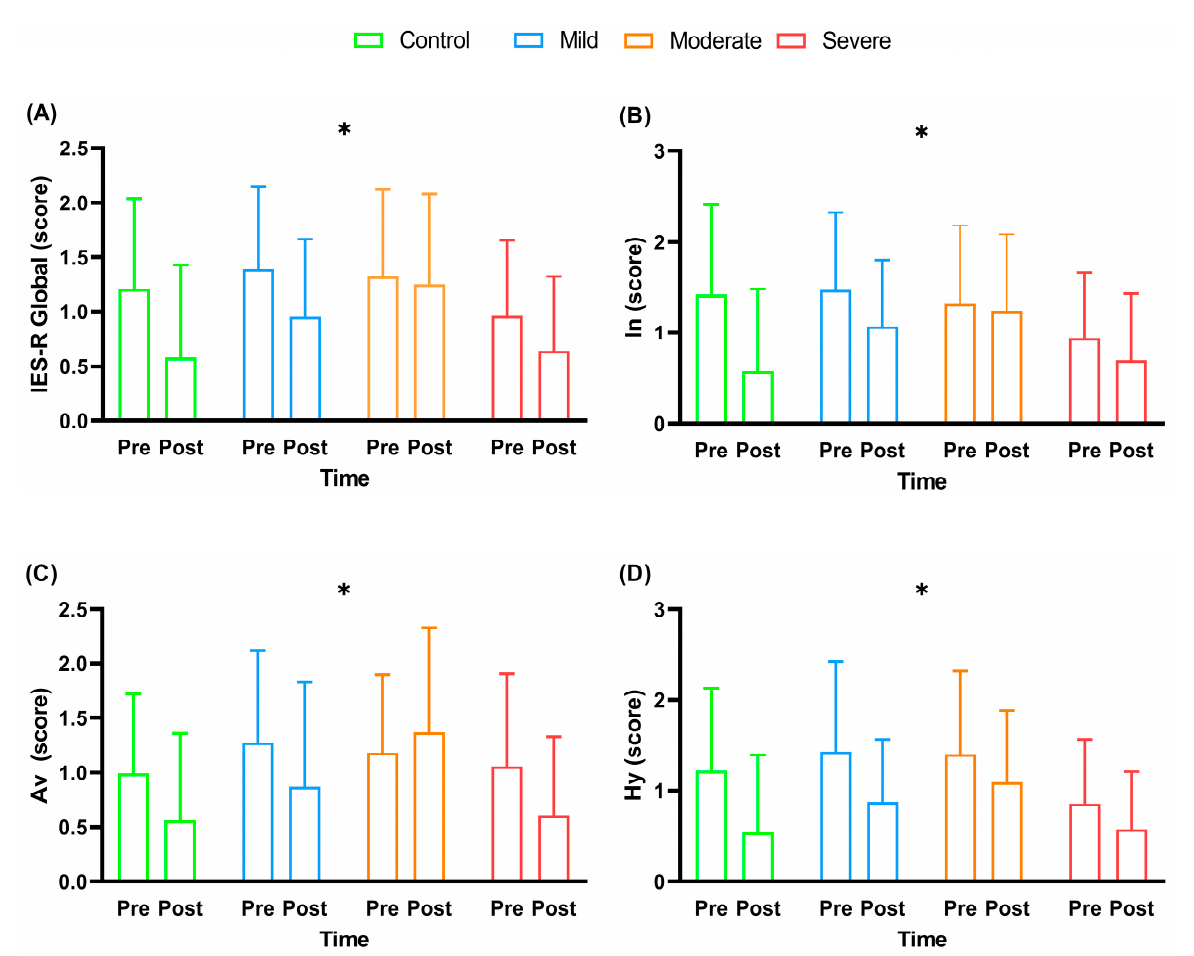
Figure 4. Impact event scale revised (IES-R) scores before and after multi-professional interventions. Data are presented as mean and standard deviation ( ± ); IES-R = Impact Event Scale–Revised; In = intrusion; Av = avoidance; Hy = hyperarousal; * = timing effect (pre- and post-intervention) with p < 0.05; Panel A = IES-R global score; Panel B = In score; Panel C = Av score; Panel D = Hy score.